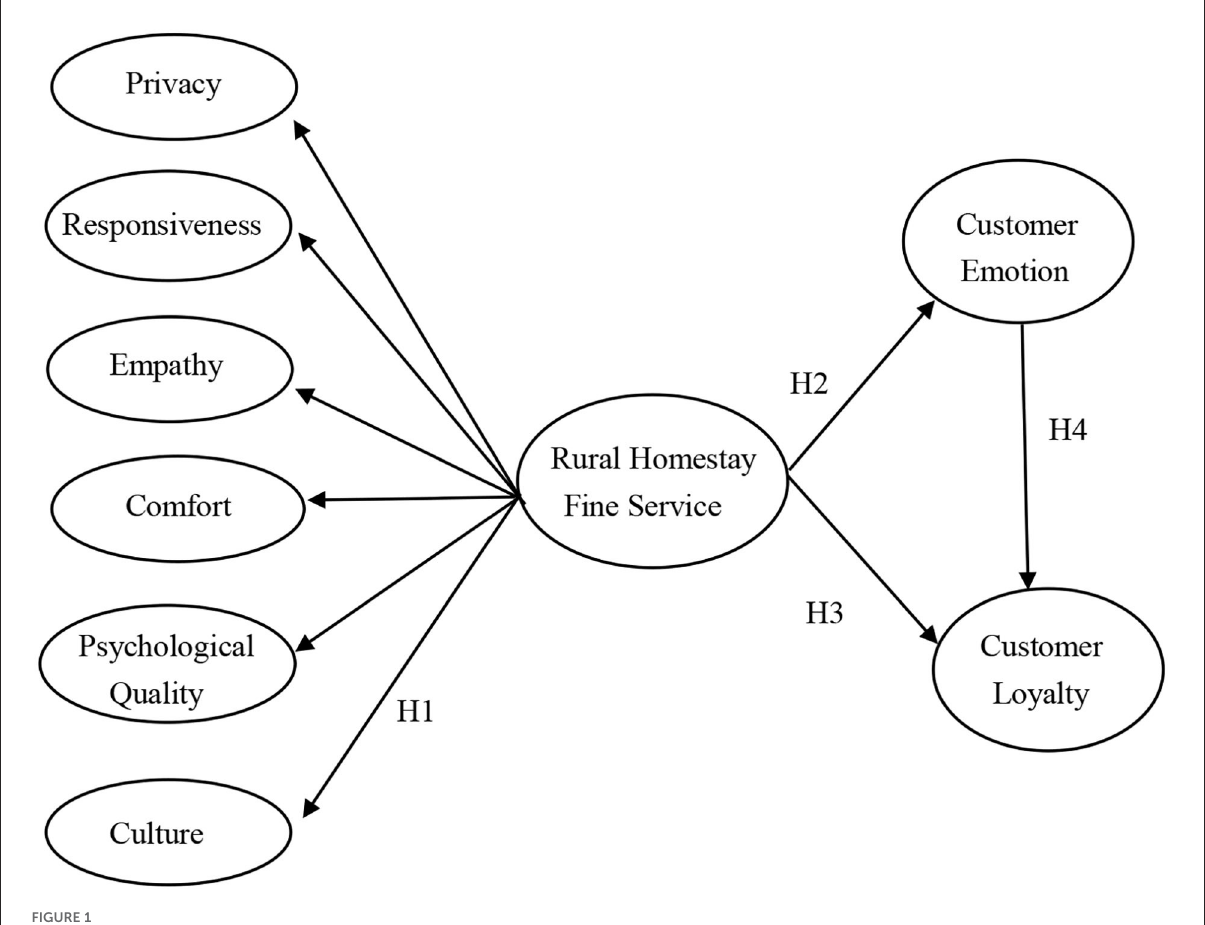
FIGURE1 Research model.